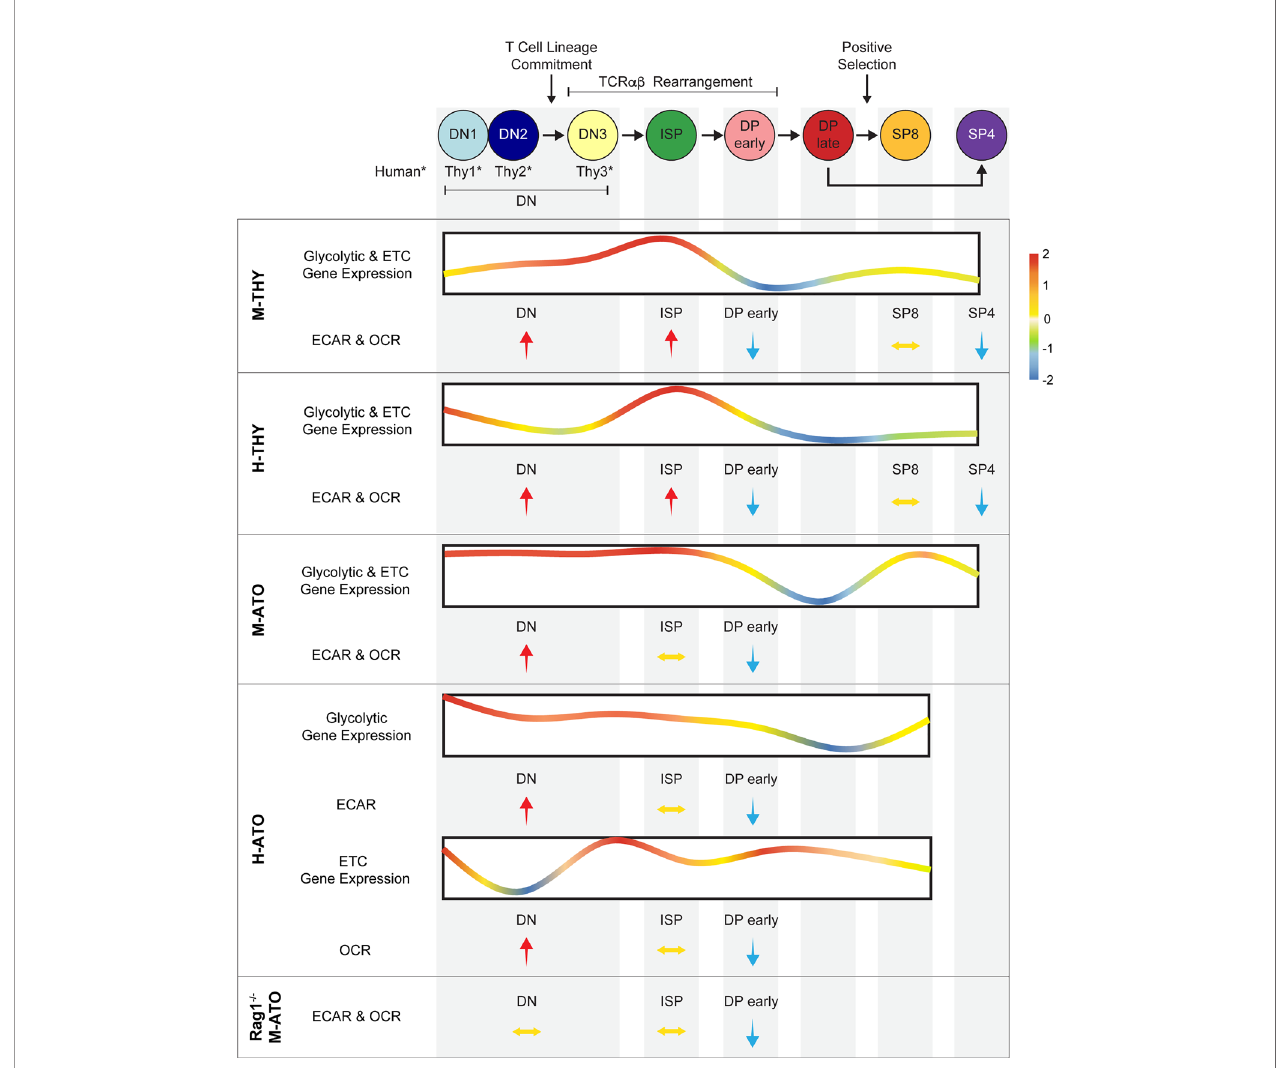
FIGURE 8 | Schematic summarizing metabolism dynamics throughout thymocyte development in M-THY, H-THY, M-ATO, H-THY, H-ATO, and RAG1 -/- M-ATO. Glycolytic and ETC gene expression patterns are represented with line plots. Color scale indicates relative fold change. Relative changes in extracellular fl ux between thymocyte populations are represented with arrows. H-ATO glycolytic and ETC results are shown separately. (*DN populations are named DN1-3 in mouse, and Thy1-3 in